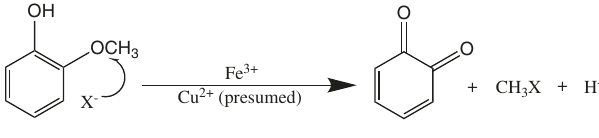
Fig. 5 Fe(III)-catalyzed 12 and presumed Cu(II)-catalyzed reaction pathway of guaiacol and halide ions to form methyl halides. X represents Cl, Br, or